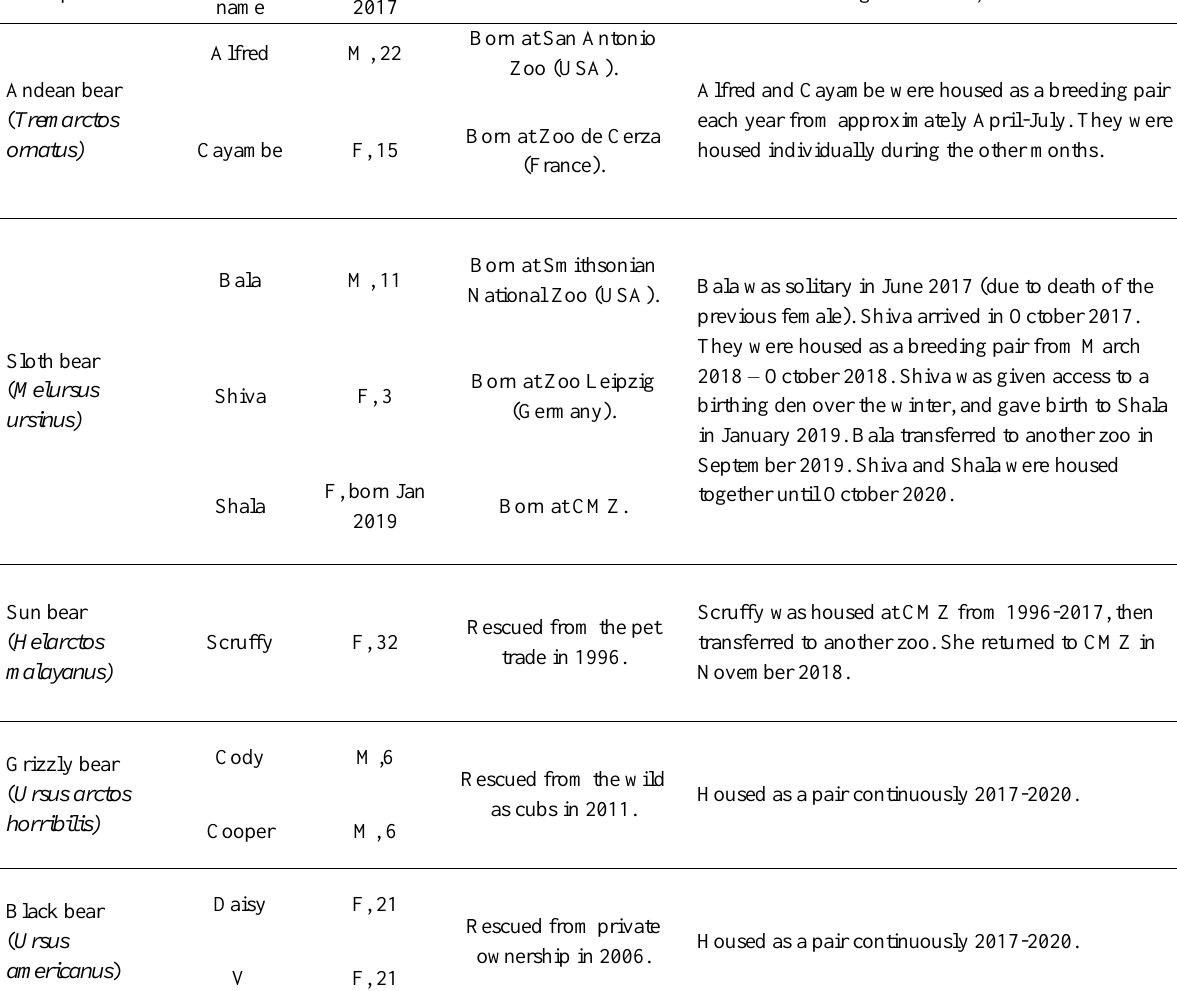
Demographic Information and Group/Housing Changes for all Bears Housed at Cleveland Metroparks Zoo,